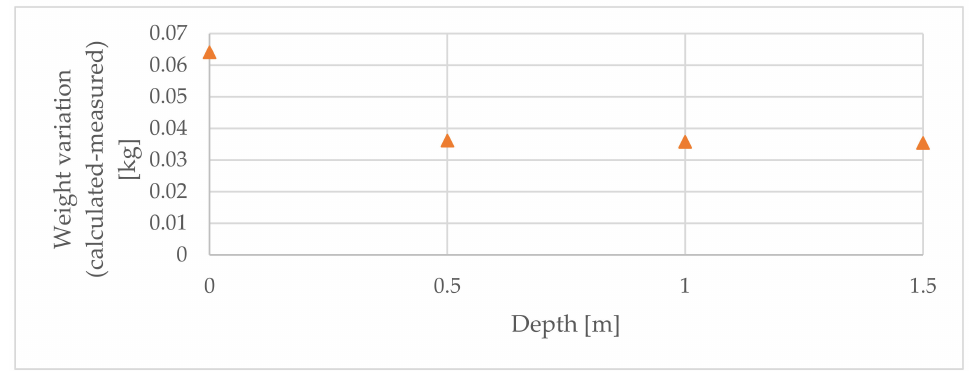
Figure 18. Buoyancy measurements at different depths (0 to 1.5 m with a 0.5 m step): comparison between measured and calculated